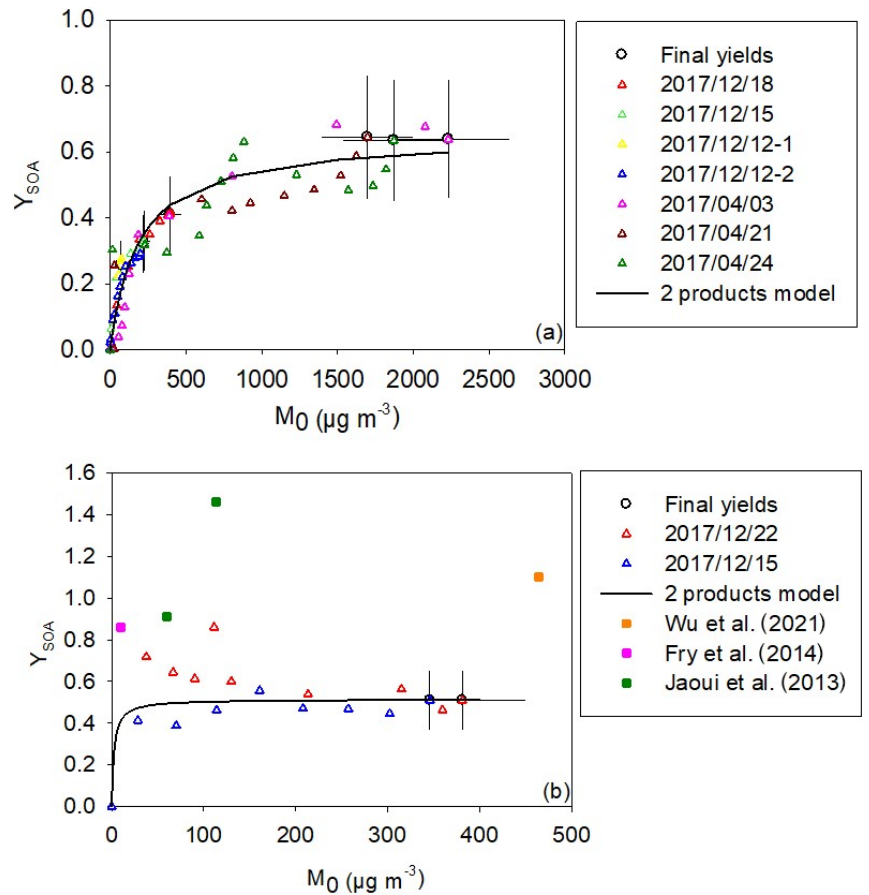
Figure 5. SOA yield as a function of the organic aerosol mass concentration measured for terpinolene (a) and for β -caryophyllene (b) . Final yields (circle marks) are shown with uncertainties. Data were fitted with a two-product model (black curve). For β -caryophyllene, literature values are presented by squared